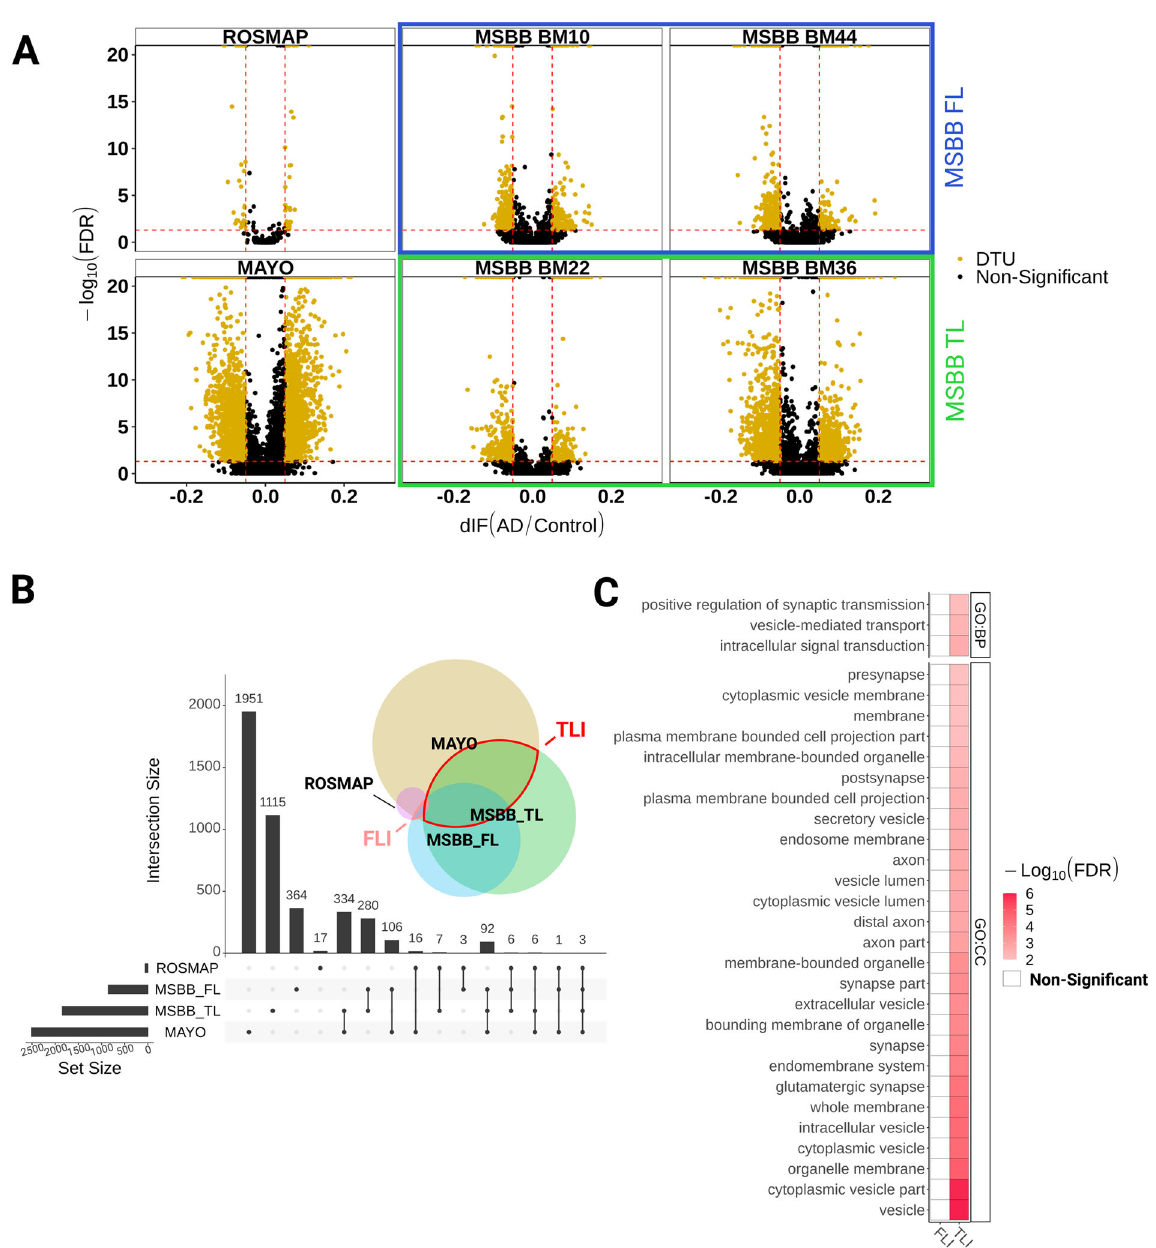
Fig. 3 Differential transcript usage analysis identi fi es gene expression alterations in AD associated with synapse transmission. A Volcano plots showing genes with differential transcript usage (gDTU, yellow dots; Differential isoform fraction (dIF) >0.05 and FDR < 0.05) in the frontal lobe (ROSMAP and MSBB_FL - BM10 and BM44) and temporal lobe (Mayo and MSBB_TL - BM22 and BM36). B Upset plot showing the total number of gDTUs identi fi ed in each dataset (horizontal bars) and the number of gDTUs exclusive of one dataset ( fi rst four vertical bars) or shared by different datasets (other vertical bars). Black dots below vertical bars indicate datasets quanti fi ed. Venn diagram illustrates the same results in colors and circle sizes. C Synapse-related terms enriched for gDTUs in the TLI are not observed in the